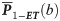
Orientation-averaged target-to-proton 1-ET probabilities P¯1−ET(b) at the SLEND/6-31G* (left panel) and /6-31G** (right panel) levels vs. the impact parameter b for the investigated (H2O)1-6.Water cluster isomers are denoted with the number code in Fig 1 (1, 2 … 6b, 6c).